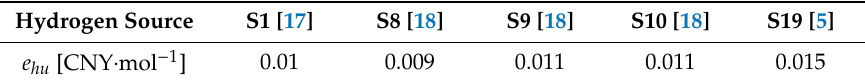
Table 2. Prices of hydrogen utilities [5,17,18].